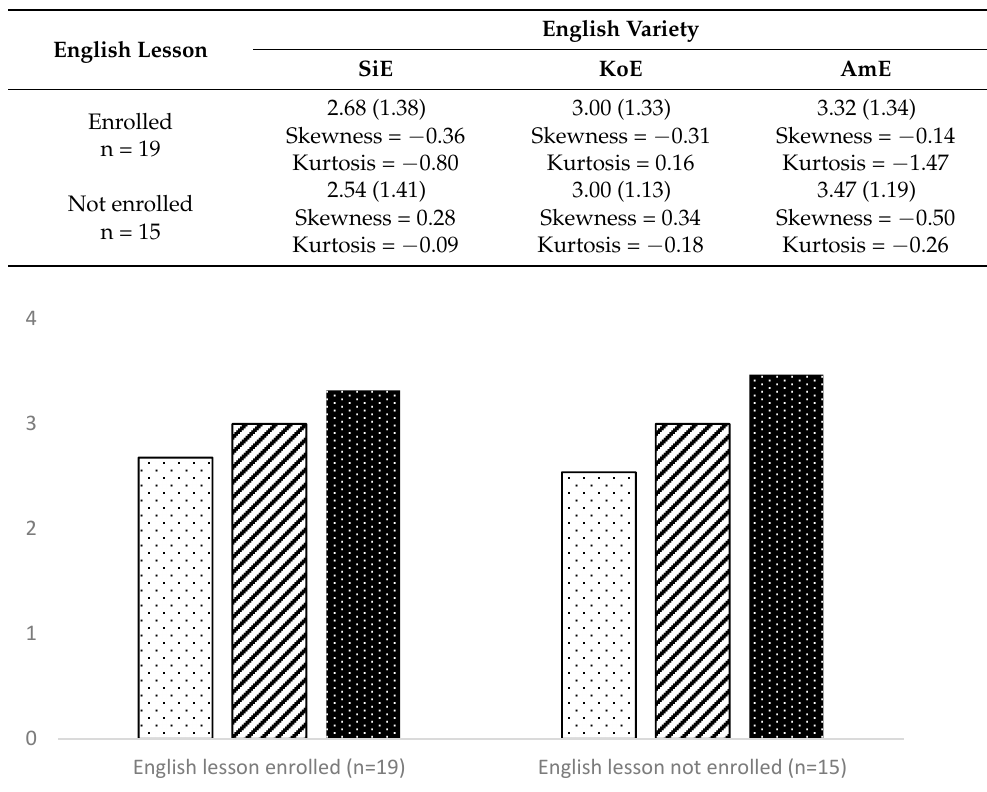
Table 2. Mean score (SD) of children’s ratings for the Singaporean, Korean, and American English speakers.